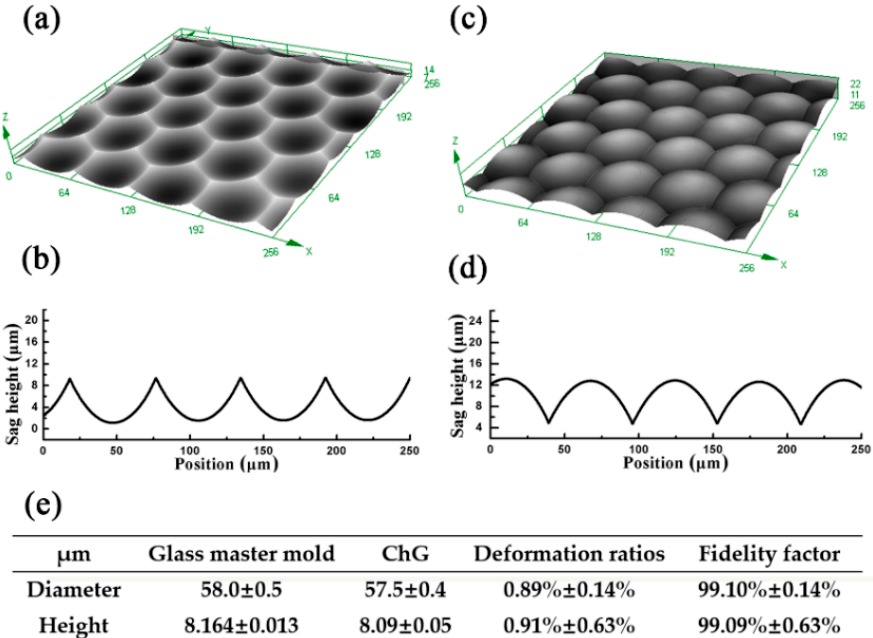
Figure 4. ( a , b ) The 3D morphology and cross-section of the concave MLAs; ( c , d ) The 3D morphology and cross-section of the convex MLAs; ( e ) The fidelity factor of convex MLAs.